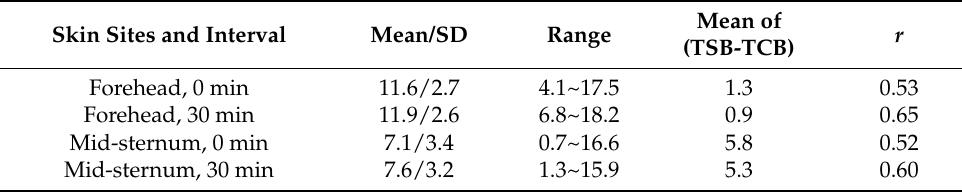
Table 2. Correlation and differences between TCB measurements among different skin sites and intervals after stopping phototherapy compared with TSB